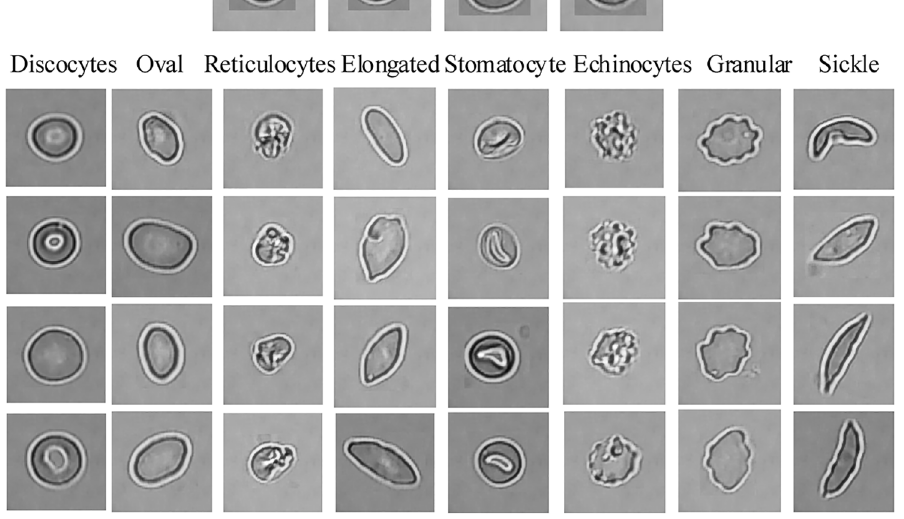
Fig 6. Size-invariant RBC patch size normalization for eight different types of diseased RBCs (horizontal) and four different groups (vertical). Images in the first row should be comparedagainstthe first column of